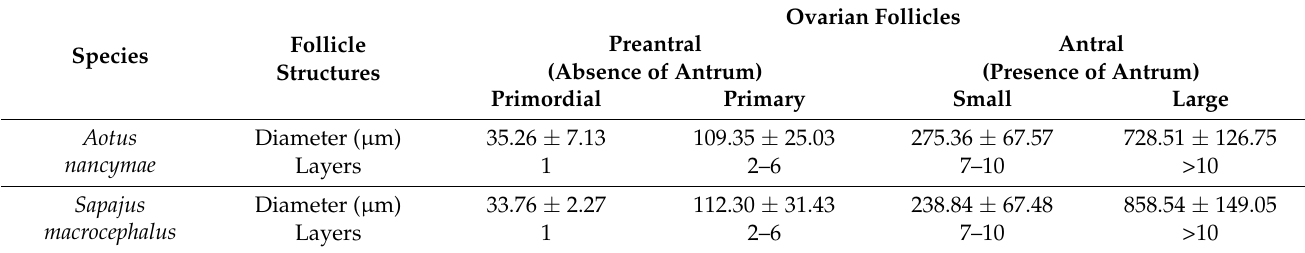
Table 1. Criteria for ovarian follicle classification in Ma’s night monkeys ( Aotus nancymae , n = 6) and large-head capuchins ( Sapajus macrocephalus , n = 6) by Mayor et al. (2016, 2015b,